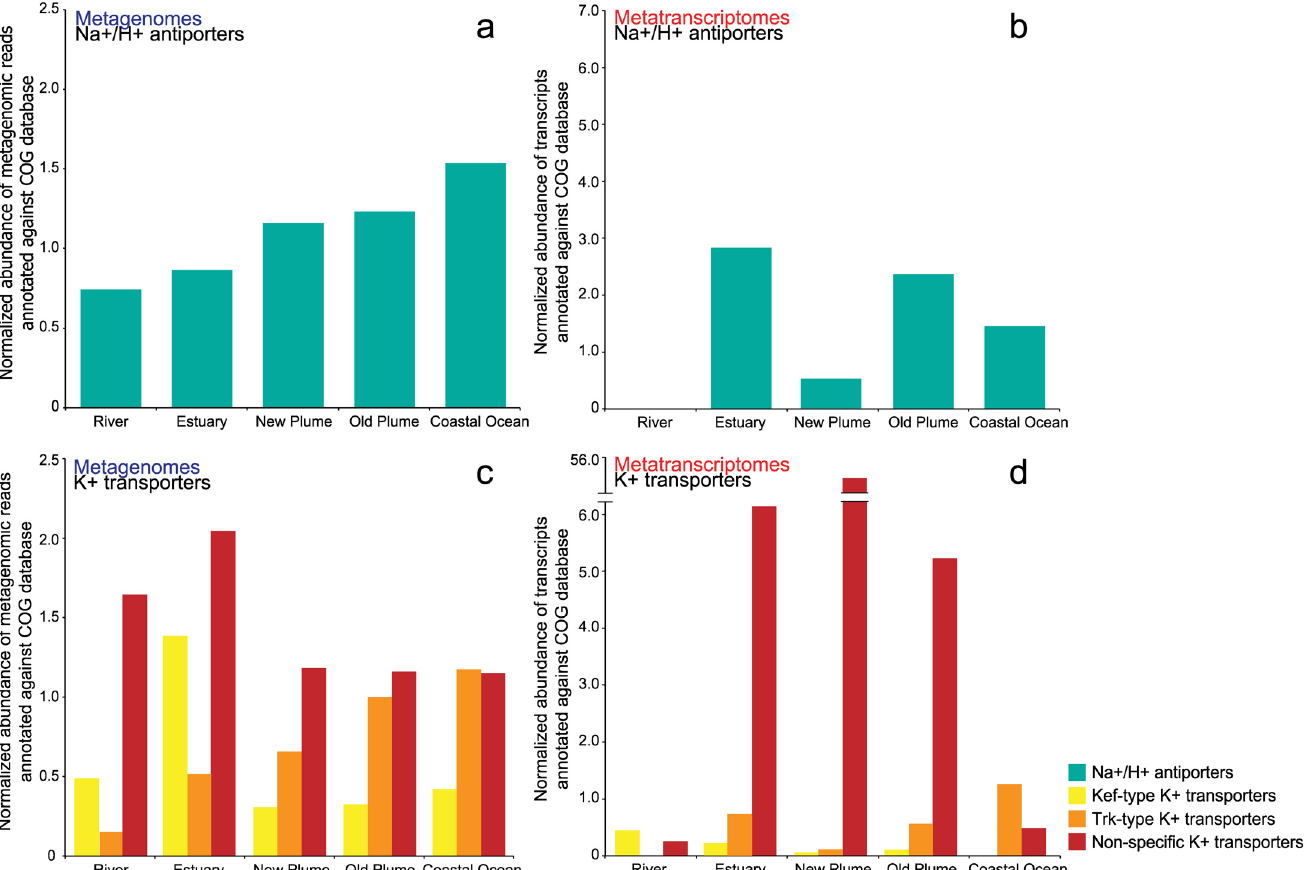
Fig 7. Changes in osmoregulators with salinity. Abundance (a) and expression (b) of Na + /H + antiporters, represented by COGs: 2111, 1006, 1863, 2212, 1320, 3004, 3067, 1055, 1757, and 1563. Abundance (c) and expression (d) of K + transporters, represented by COGs: 569, 3158, 2060, 2156, 2216, and